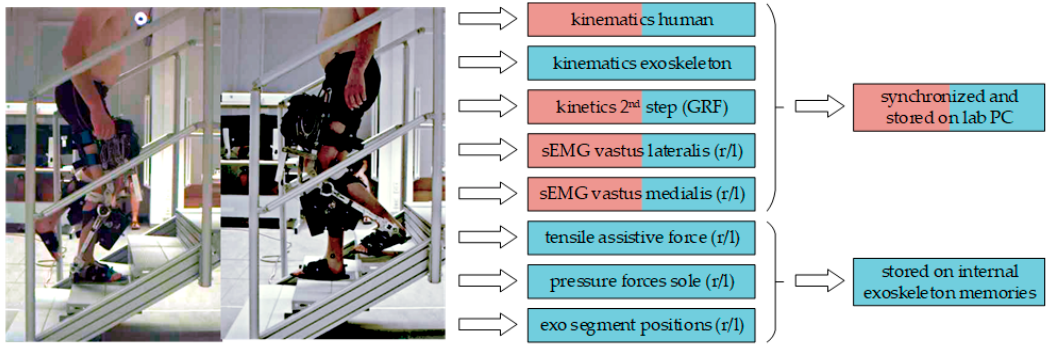
Figure 3. Measured and stored data during stair ascents and descents with the novel exoskeleton system eBUS (bright blue). The red bares indicate data that are measured during stair ascent and descent without eBUS as a reference. r/l stands for right and left leg.